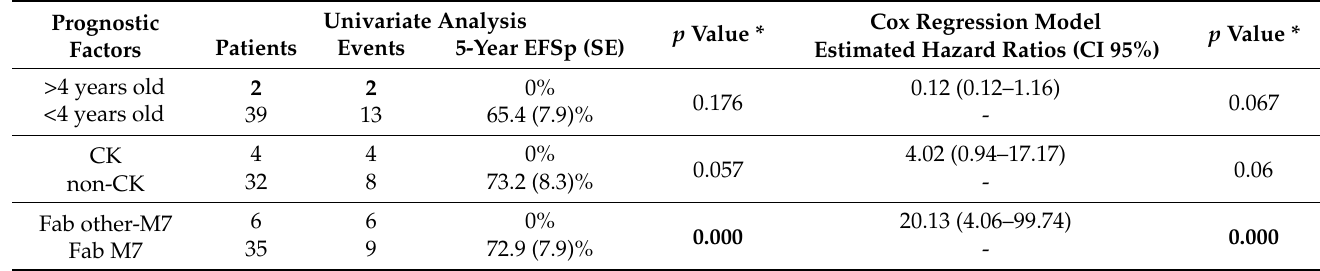
Figure 2. 5-years EFSp for total DS-AML population and according to prognostic factors. ( a ) 5-years EFSp for total DS-AML population, ( b ) 5-years EFSp according to complex karyotype, ( c ) 5-years EFSp according to immunophenotype, ( d ) 5-years EFSp according to age > or < 4-years old. Table 2. Univariate and multivariate cox regression analysis for DS-AML outcome prognostic